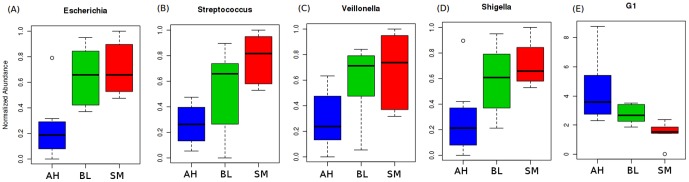
Box-plots showing the abundances of the taxonomic groups significantly differing across the three groups (AH, BL and SM) of gut microbiomes.